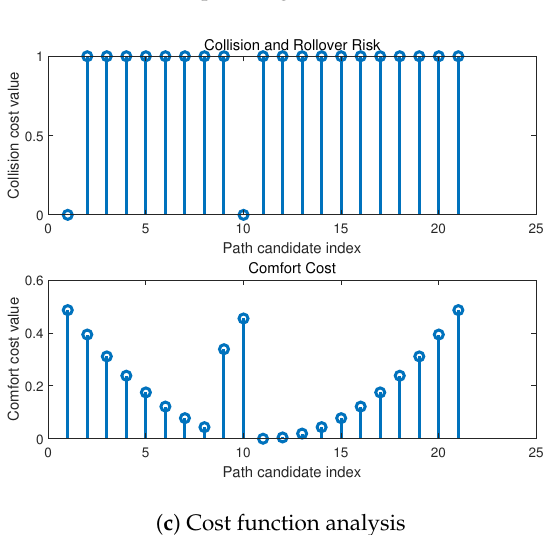
Figure 13. Multiple obstacle path selection: ( a ) an XY view on obstacles and the boundary; the light color indicates z > 0; the dark color indicates z < 0; ( b ) path selection result in a three-obstacle model: the selected path avoids two rollover risk obstacles and passes over a non-rollover risk obstacle; ( c ) path candidate collision and rollover cost analysis and comfortability cost analysis